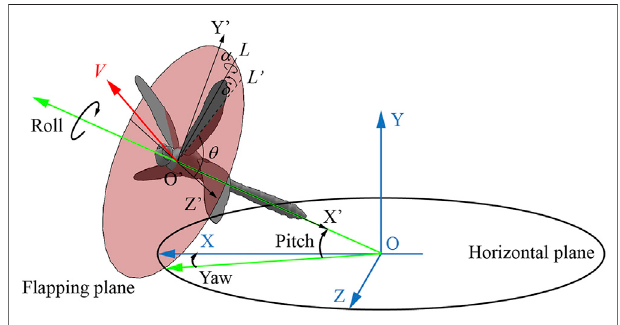
FIGURE 2 | De fi nition of kinematic